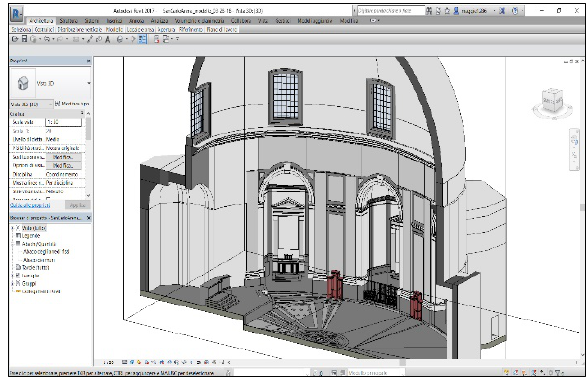
Figure 5. H-BIM model in Autodesk Revit